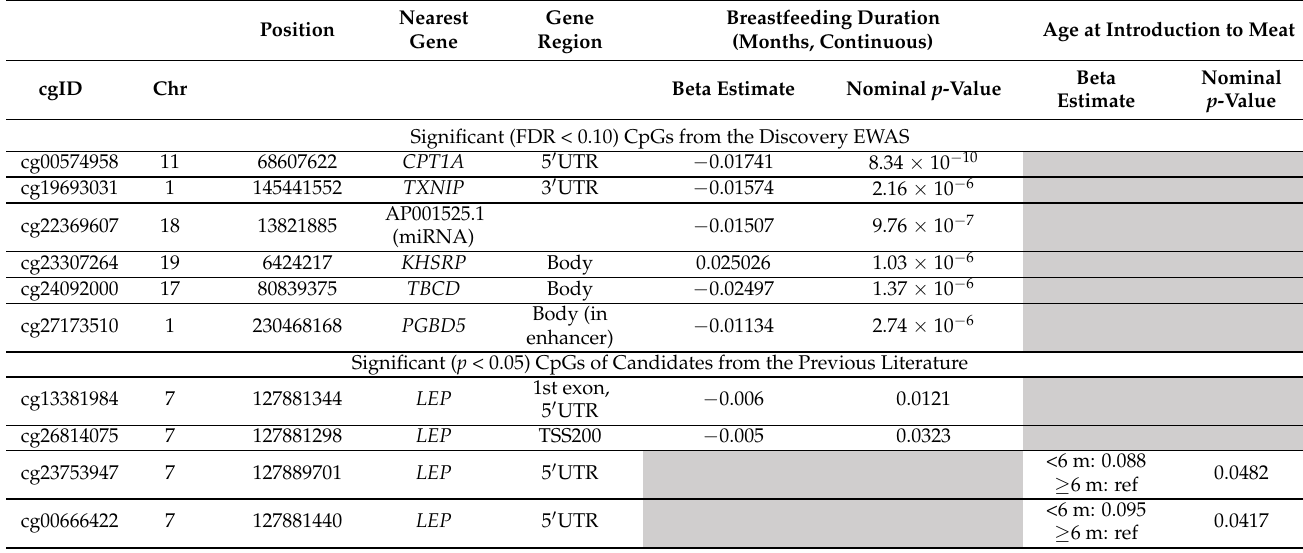
Models adjusted for age at methylation measure, sex, race/ethnicity, cell composition, and platform. Infant diet exposures examined include breastfeeding duration, exclusive breastfeeding duration and age at introduction of non-gluten-containing cereals (rice, oat), gluten-containing cereals (wheat, barley, rye), fruit (not including juice), vegetables, and meat. Only those showing a significant association with methylation at a CpG site are displayed in the table. Shaded grey cells indicate no association (FDR ≥ 0.1 for EWAS and nominal p ≥ 0.05 for candidate CpG analysis). TSS200: 0–200 bases upstream of the transcriptional start site